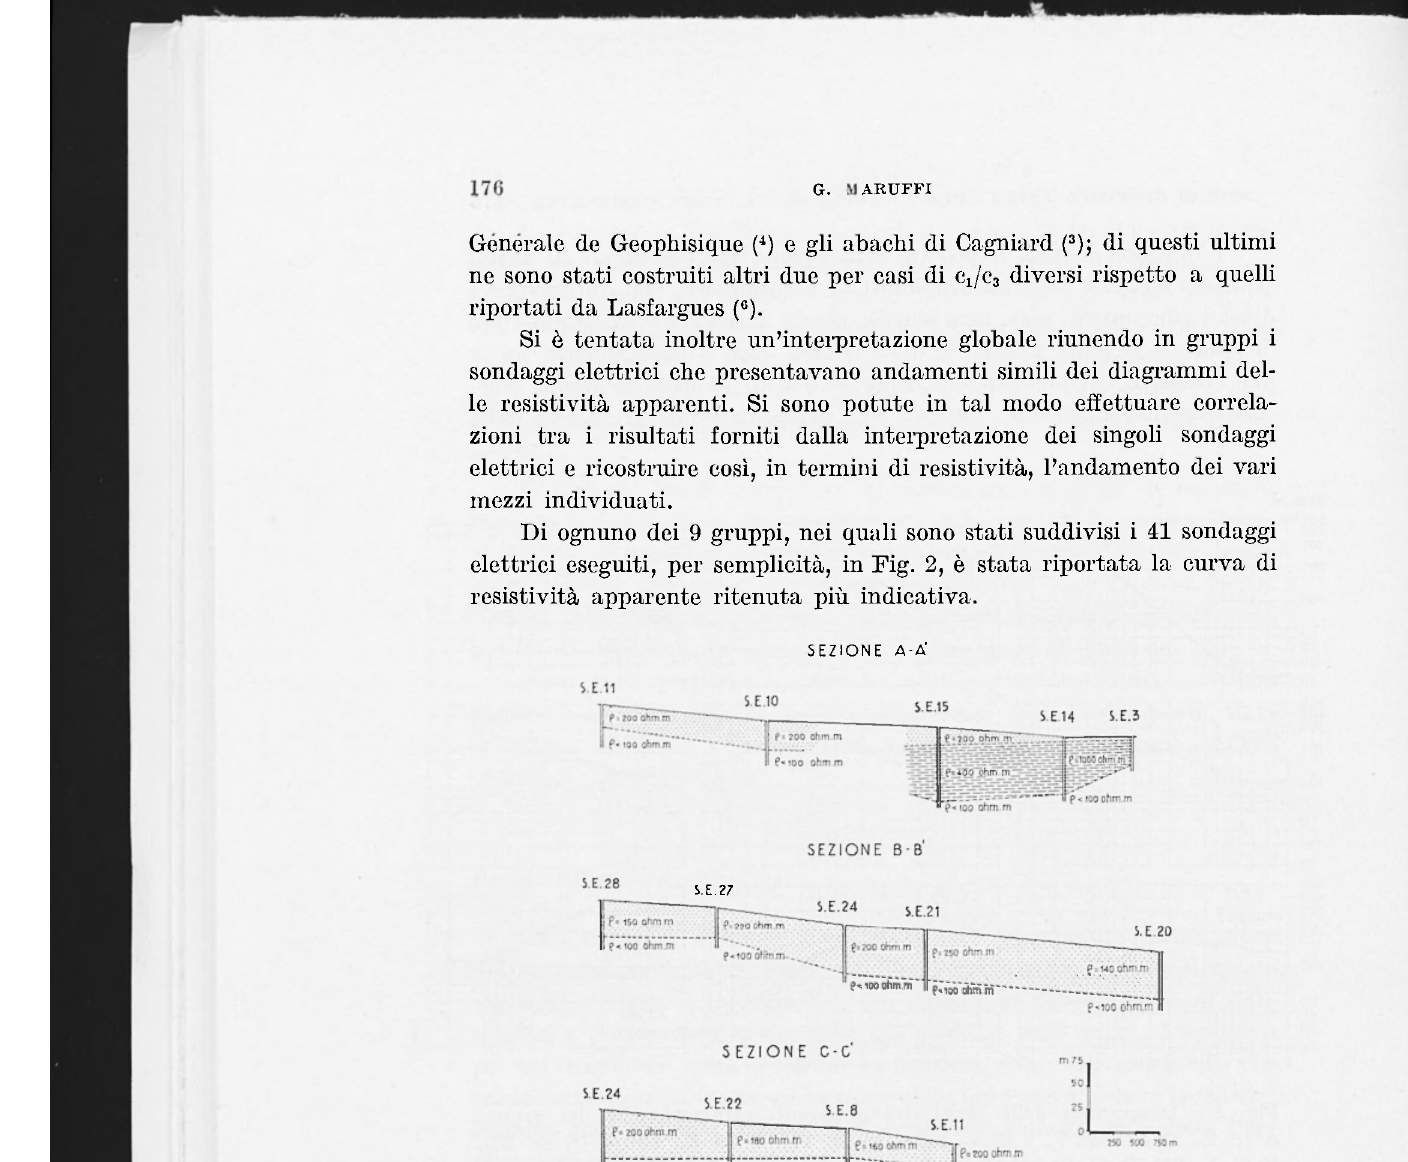
Fig. 3 - Sezioni elettrostratigraficlie.